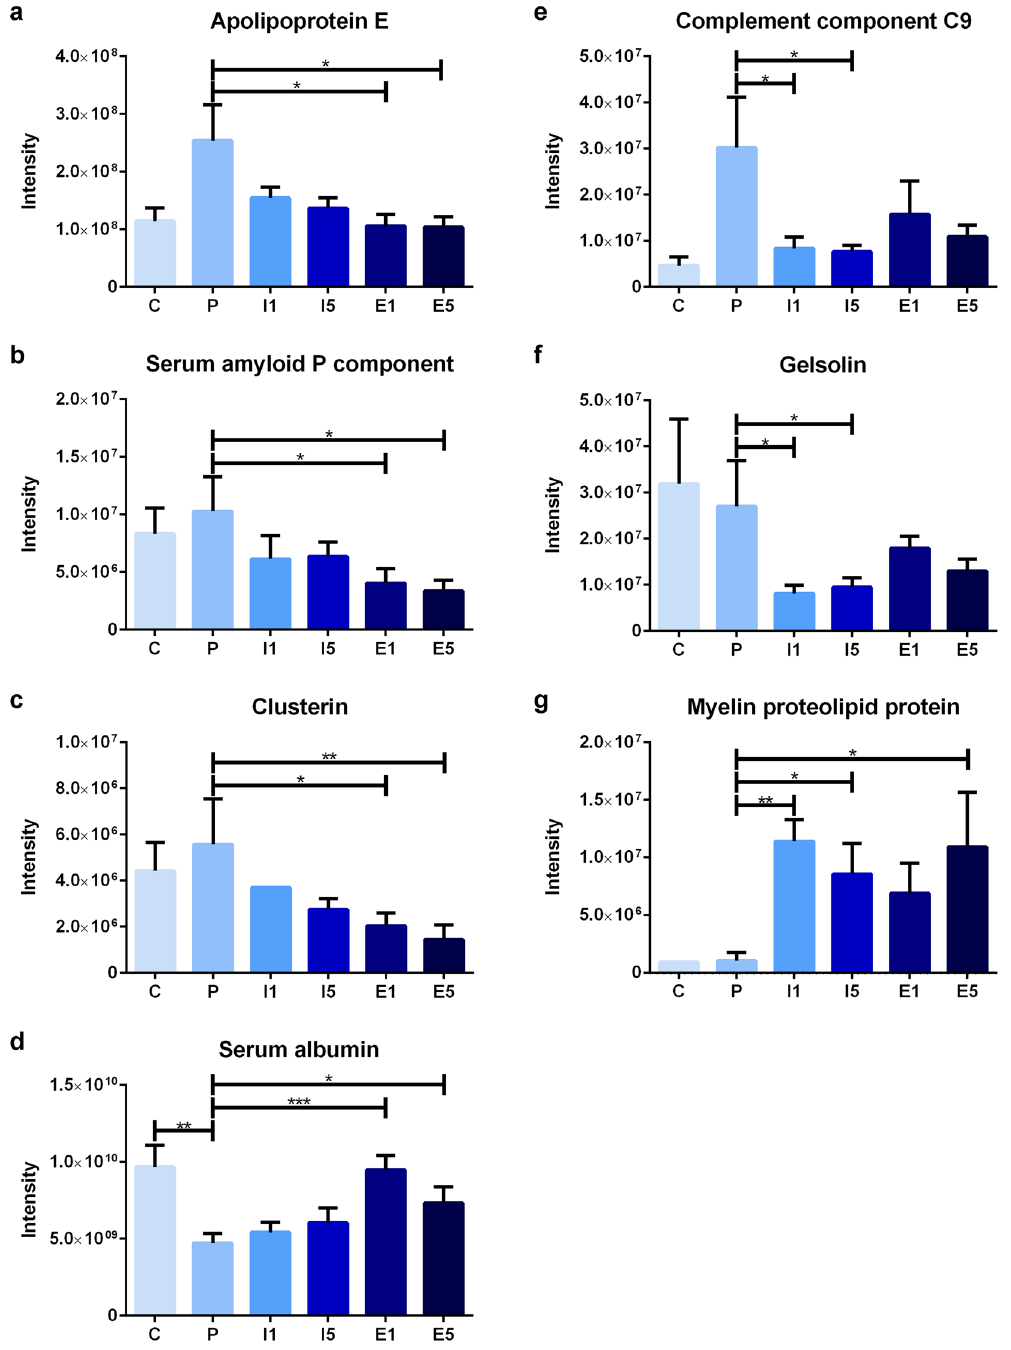
Figure 5. Intensity of immunoprecipitated protein for all groups; apolipoprotein E ( a ), serum amyloid P component ( b ), clusterin ( c ), serum albumin ( d ), complement component C9 ( e ), gelsolin ( f ) and myelin proteolipid protein ( g ); control (C, n = 5), placebo (P, n = 10), IFN- β on day 1 (I1, n = 10), IFN- β on day 5 (I5, n = 10), etomoxir on day 1 (E1, n = 10) and etomoxir on day 5 (E5, n = 10). All data are presented as the mean ± SEM. Results from the unpaired t-tests showed statistically significant differences in the immunoprecipitated protein intensities between P and E1 and E5 ( a – d ) and between P and I1 and I5 ( e – g ). Number of asterisks indicates level of statistical significance ( * p < 0.05, ** p < 0.01 and *** p <